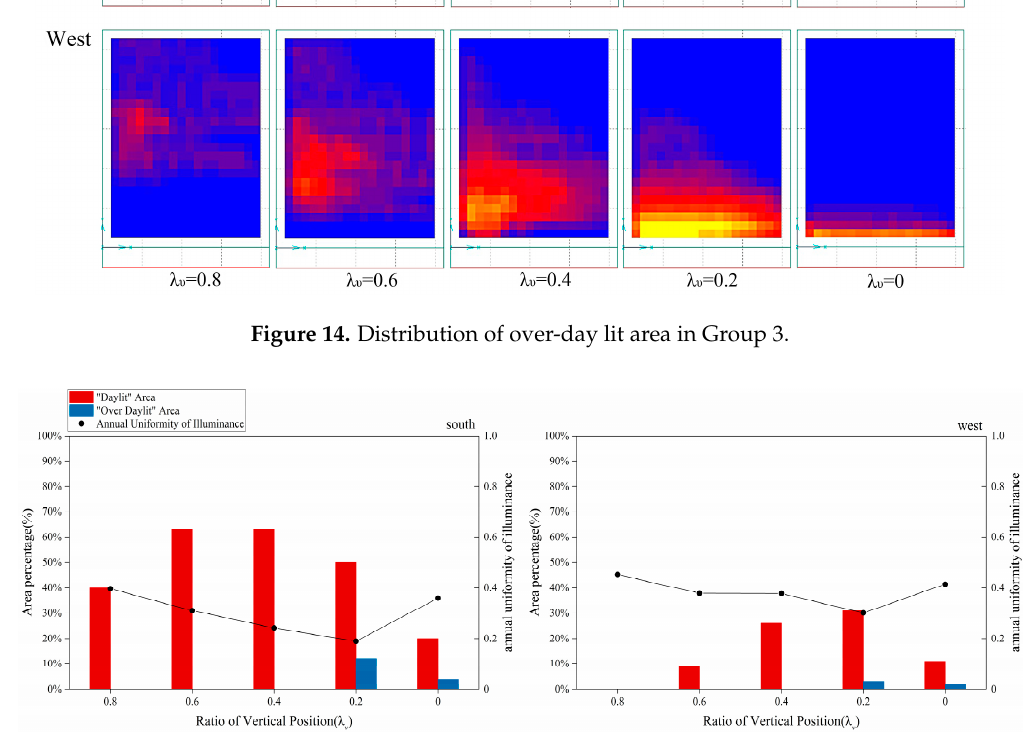
Figure 15. Shading and daylighting performance for the tested cases in Group 3.